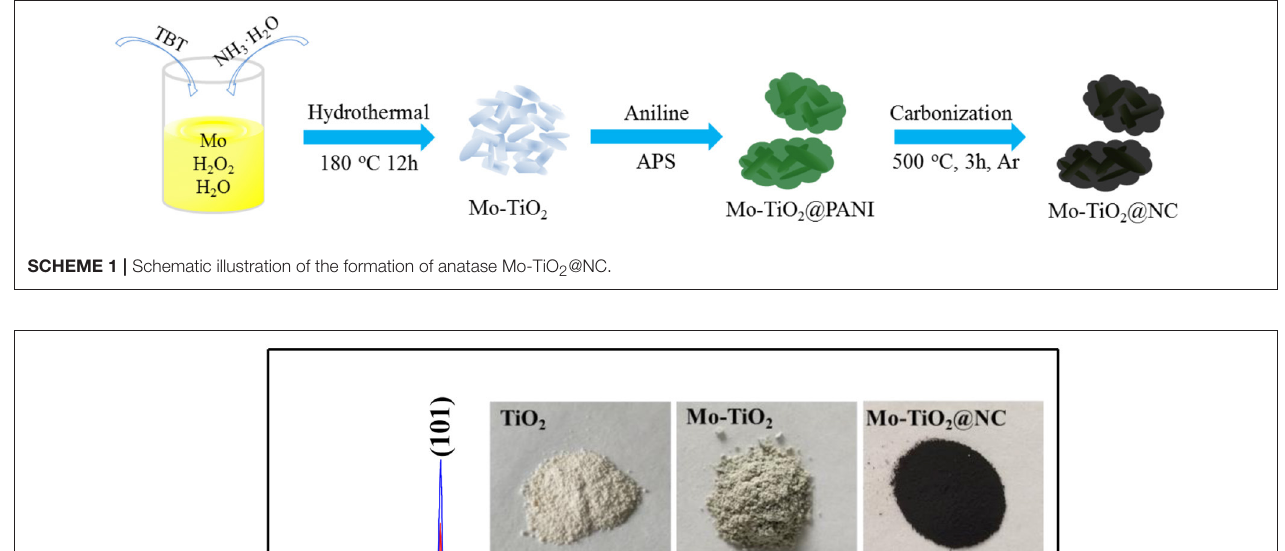
Frontiers in Materials |